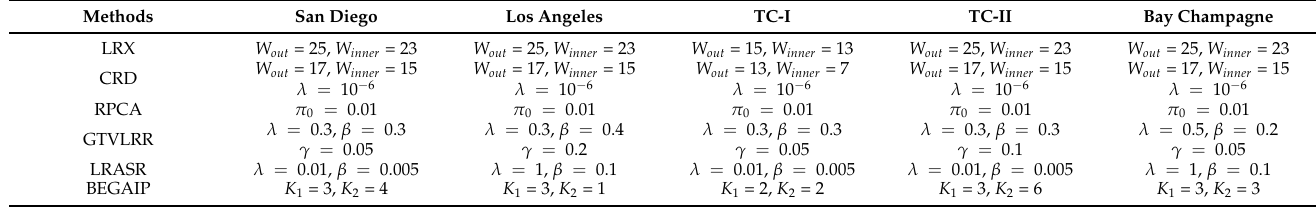
Table 2. Parameters Settings of algorithms on the data sets.